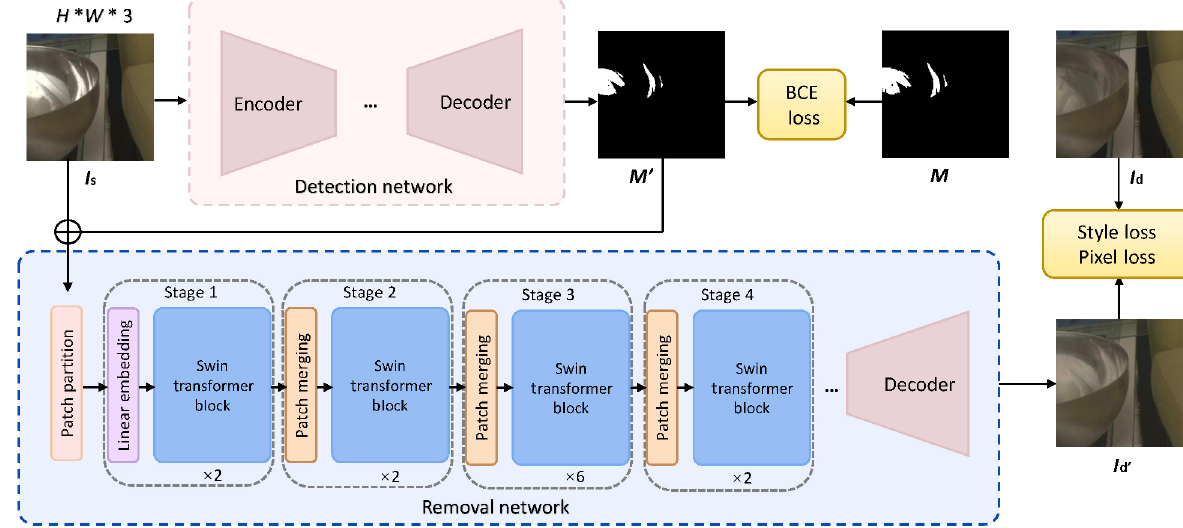
Fig. 2 Proposed specular highlight detection and removal framework. Given an input image I s with specular highlights, an encoder–decoder detection network outputs a mask M 0 indicating highlight areas. Using the detection results as guidance, a Unet-Transformer provides a specular-free diffuse image I d 0